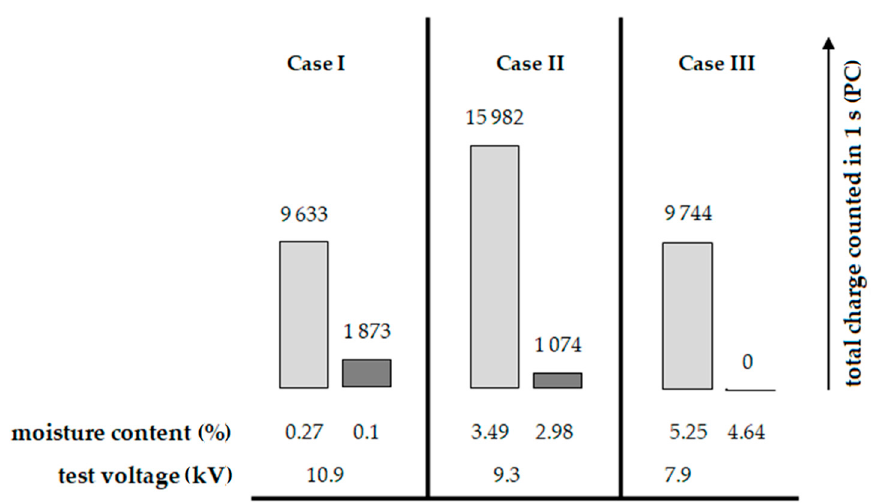
Figure 9. Total charge carried by current pulses during 1 s; ■ — 0.25 mm thick Nomex ® 910 paper samples, ■ — 0.25 mm thick cellulose paper.